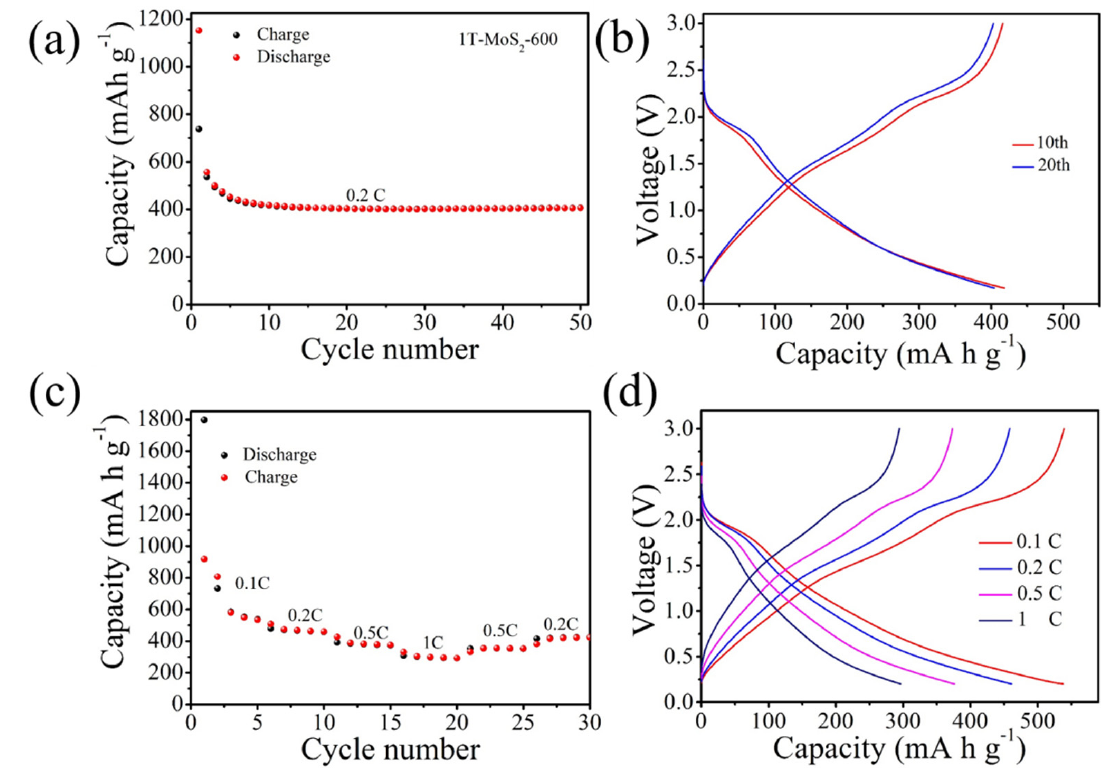
Figure 5. ( a ) Cycling performance of 1T − MoS 2 − 600 at 0.2 C, ( b ) the corresponding charge–discharge profiles at 0.2 C, ( c ) rate performance of 1T − MoS 2 − 600, and ( d ) the related charge–discharge profiles at varied current densities from 0.1 to 1 C.